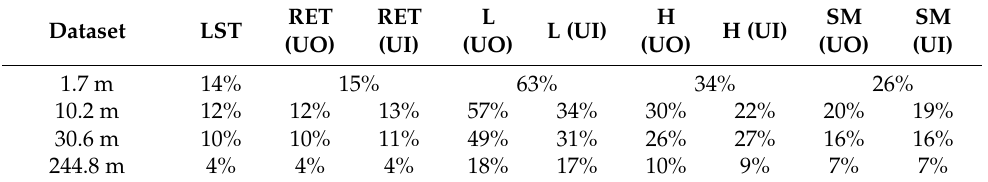
Table 5. Variation coefficient for the variables shown in Figure 9 across all the tested scales. Data for the 734.4 m scale not included, since the value is, by definition, 0%. Model results described both from the Upscaled Outputs (UO) and Upscaled Inputs (UI) approaches.